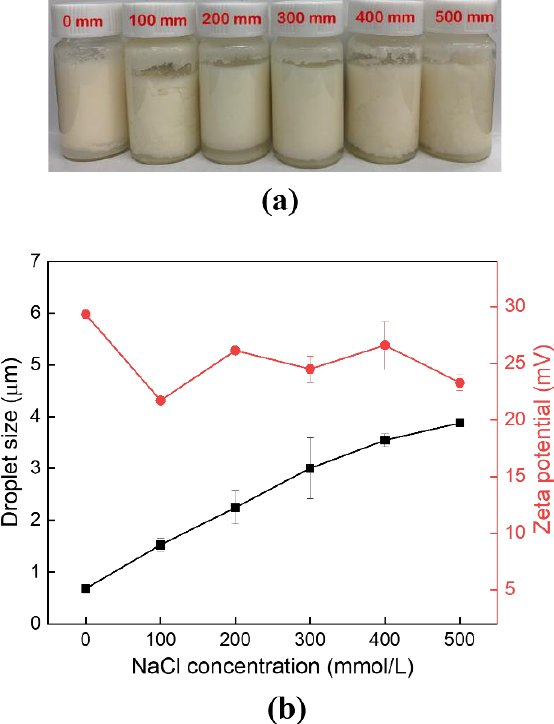
Figure 9. Effects of ionic strength on appearance ( a ) and droplet size ( b ) of Pickering emulsions stabilized by CS-PA-CD nanoparticles.